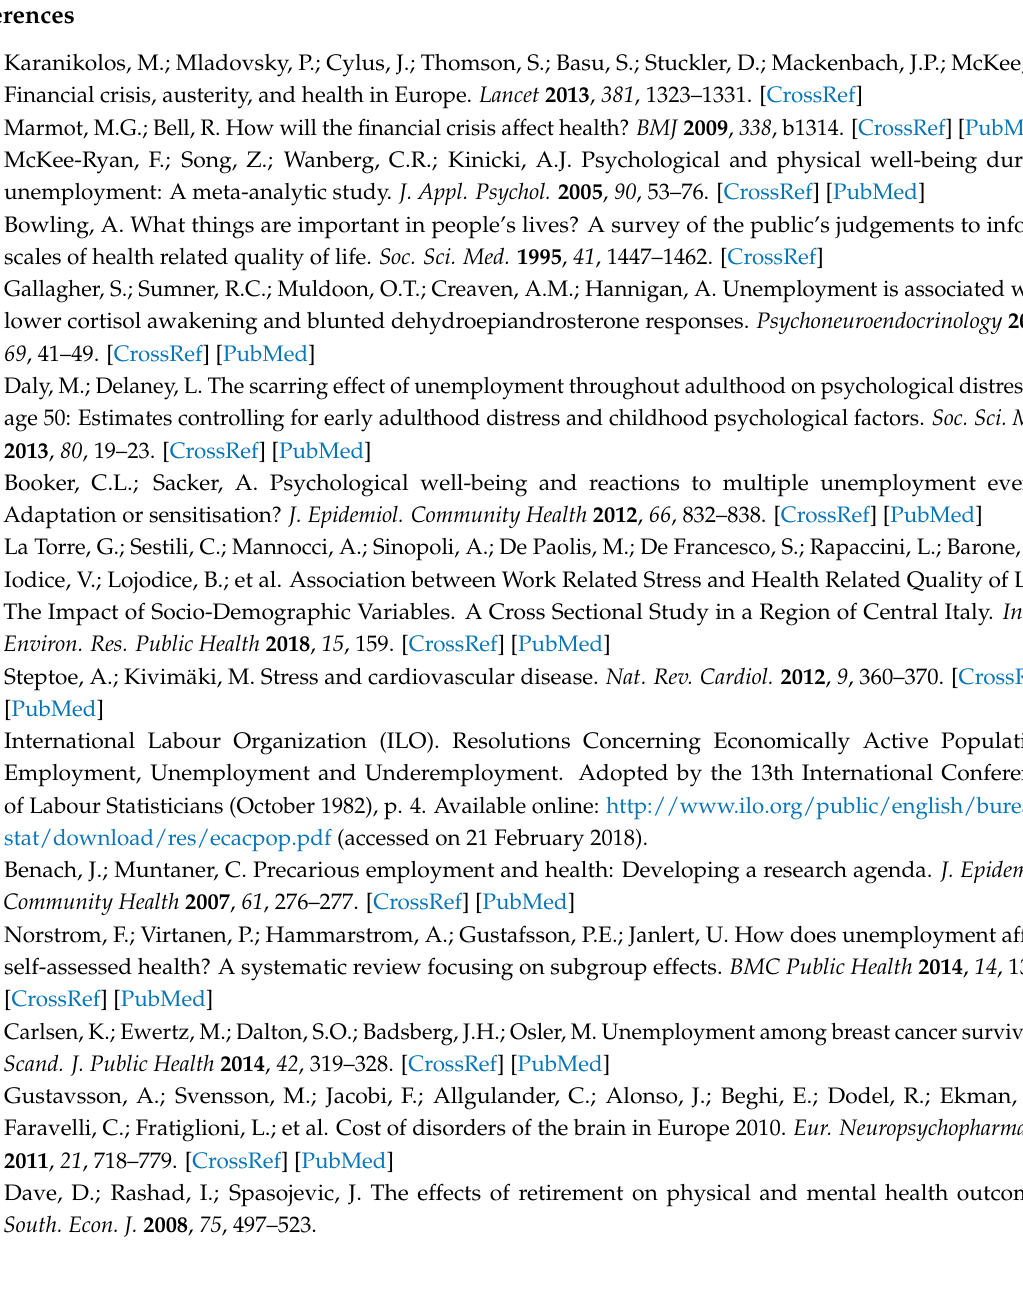
Supplementary File 1: dataset used for the manuscript analyses. Table S1: Results of the simple and selected multiple logit quasi-binomial regression models overall and by country: crude and adjusted associations (i.e., odds ratio) with